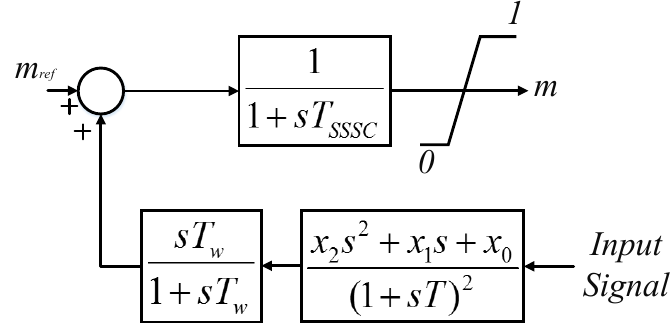
Figure 6. SSSC magnitude controller with a damping stabilizer.